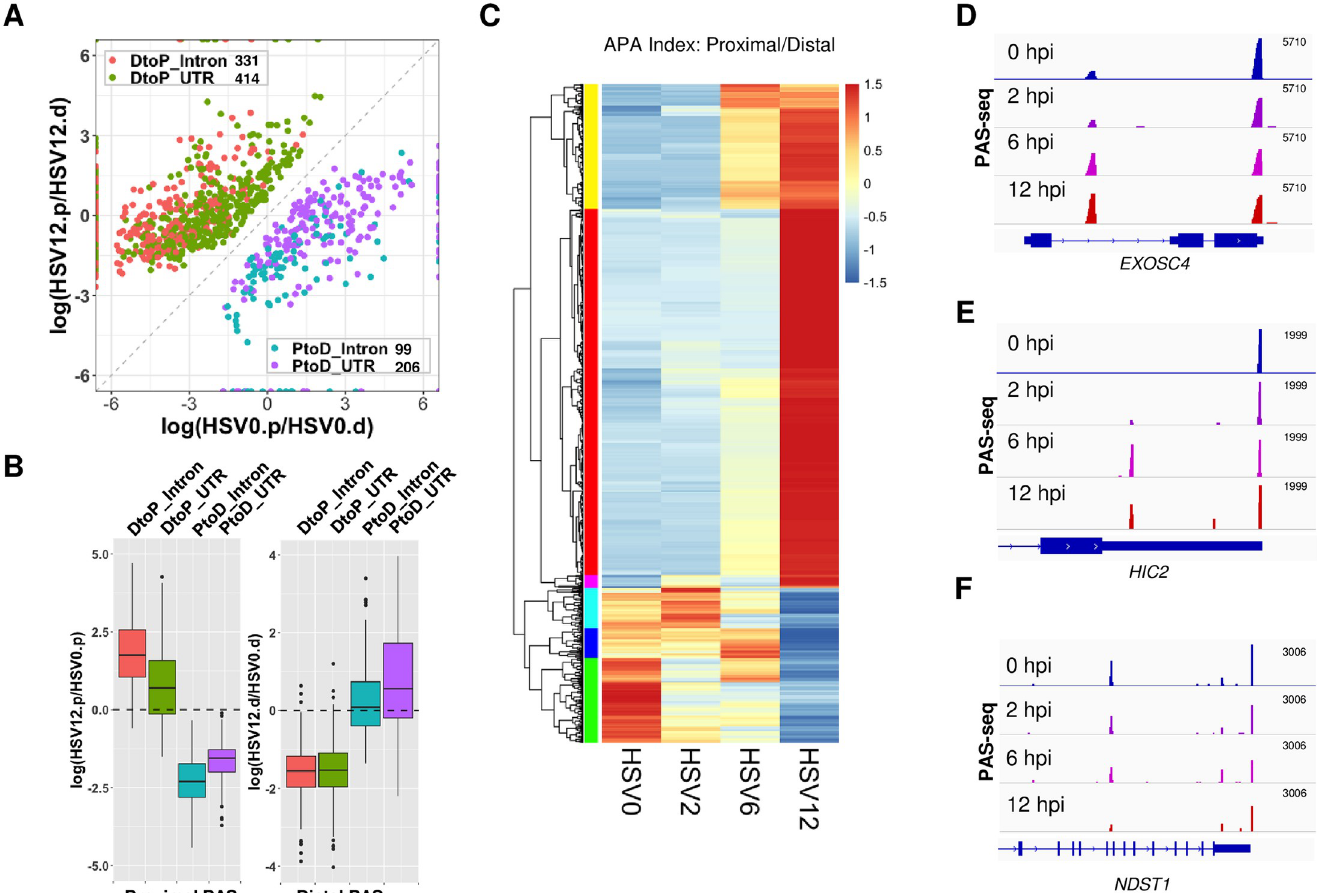
Fig 1. HSV-1 infection induces widespread and dynamic APA changes. (A) A scatter plot of HSV-1-induced significant APA changes in HeLa cells (FDR < 0.05, at least 15% of the transcripts shifted). HSV0.p or HSV12.p: read counts for the proximal PAS in cells at 0 or 12 hpi; HSV0.d or HSV12.d: read counts for the distal PAS in cells at 0 or 12 hours post infection. DtoP: a distal to proximal shift; PtoD: a proximal to distal shift. Intron: shifts involving an intronic PAS. UTR: both PAS are located in the 3’ UTR. (B) Relative read count changes at proximal (.p) or distal (.d) PAS in the four groups of APA shifts. (C) A heat map showing the APA index (proximal/distal read count ratio) of all the genes with significant APA shifts as shown in (A). Data was scaled by row. Color bars on the left denote the 6 groups that displayed similar kinetic patterns. (D-F) PAS-seq tracks of example